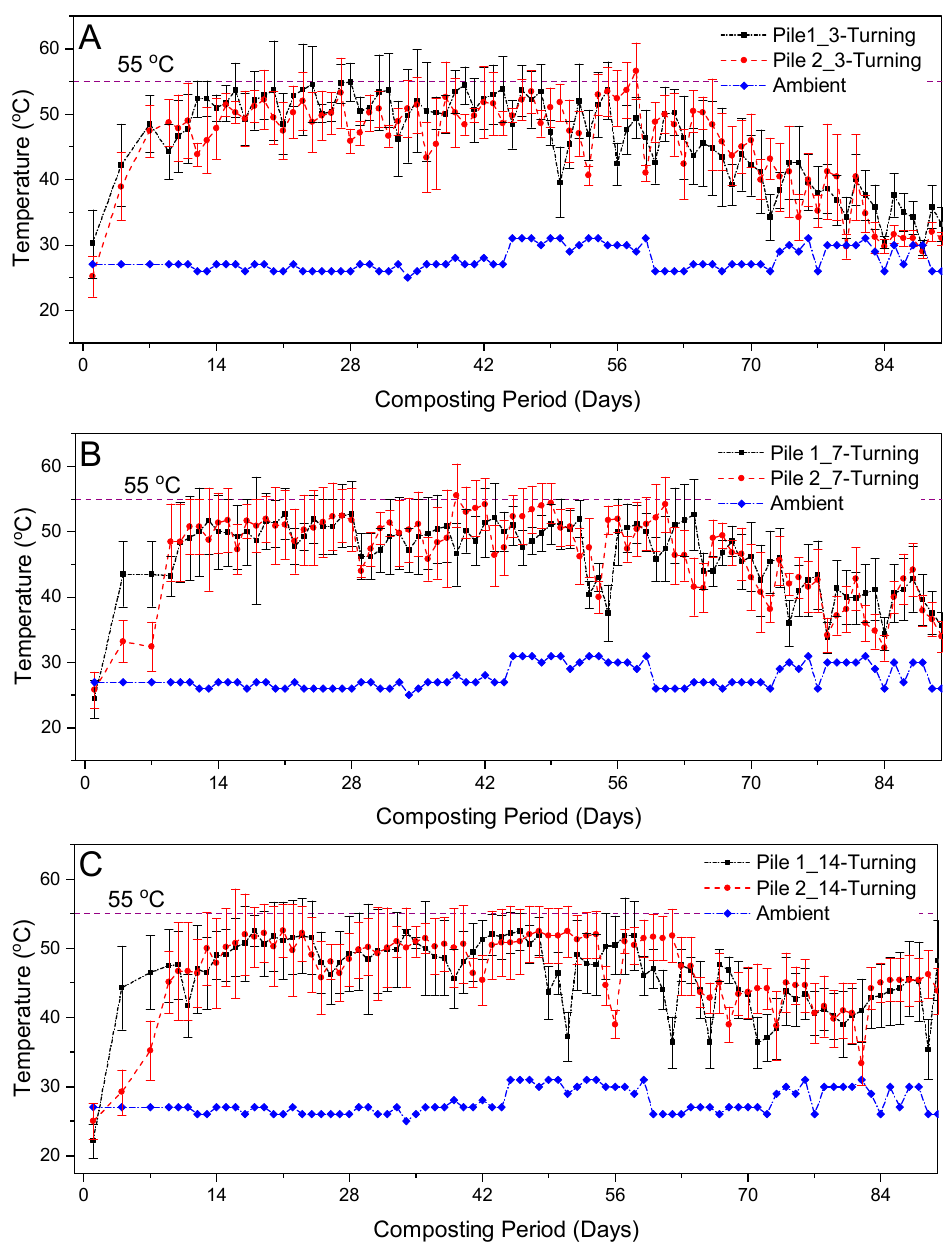
Figure 1. Temperature evolution during composting of Fecal Sludge (FS) and sawdust using ( A ) 3 days turning frequency, ( B ) 7 days turning frequency, ( C ) 14 days turning frequency. In ( A – C ) error bars represent the standard deviation of the bottom, center, left side and right-side pile temperatures.